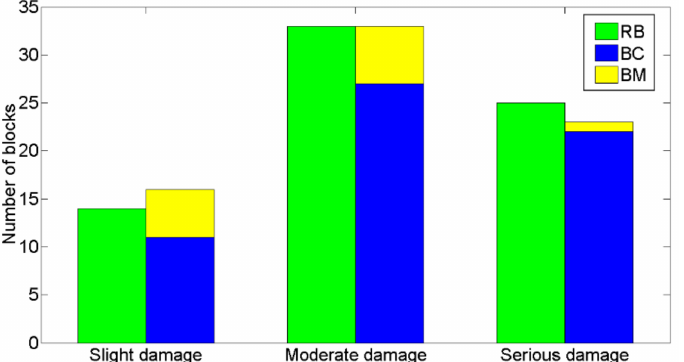
Figure 12. Comparison histograms of estimated damages using the proposed method with real damages which is shown in Figure 4. The legends of RB, BC and BM represent the blocks of real damage, the blocks correctly identified using the proposed method and the blocks misclassified using the proposed